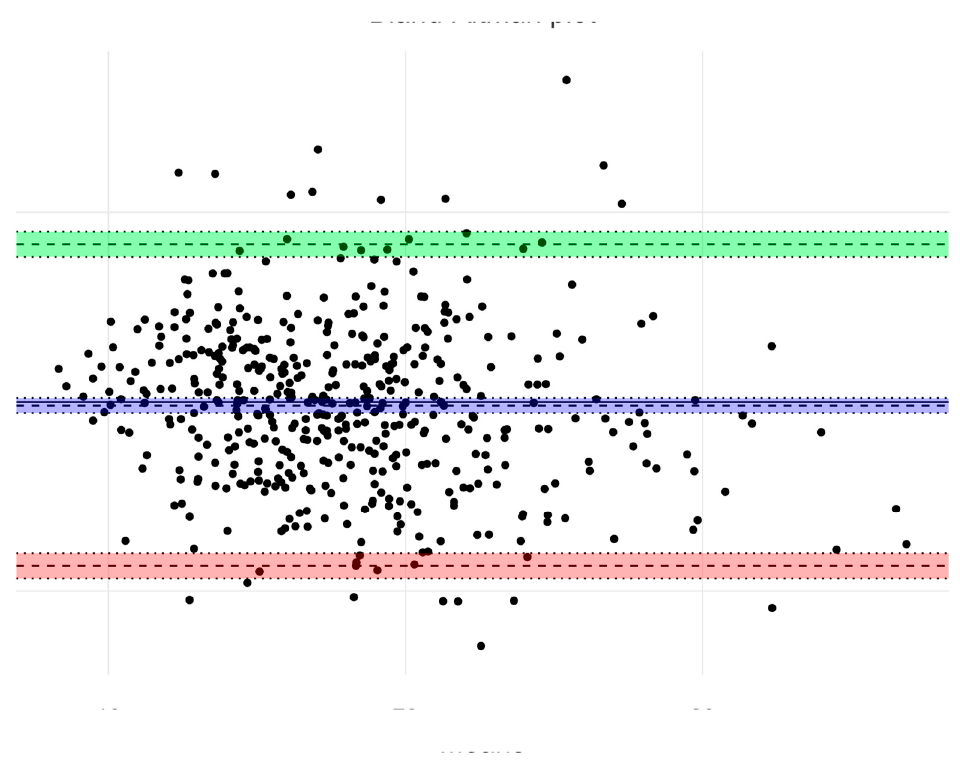
Figure 2. Bland–Altman Plot of agreement between fat mass estimation using bioimpedance analysis (BIA) and Matiegka method. The overall agreement is relatively high, with a mean bias value − 0.18.